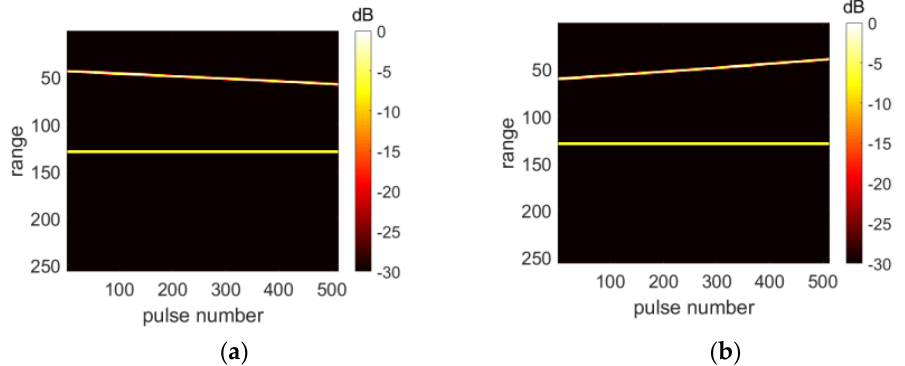
Figure 2. Comparison of range profiles: ( a ) range profile of unambiguous scattering centers; ( b ) range profile of ambiguous scattering centers.